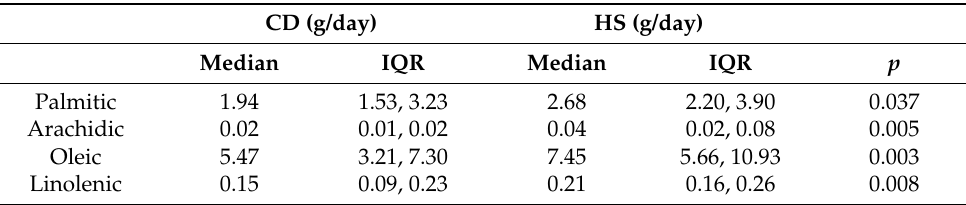
Table 2. Medians ± IQR of 7-day fatty acid oral intake in CD patients and healthy subjects. CD (g/day) HS (g/day) Median